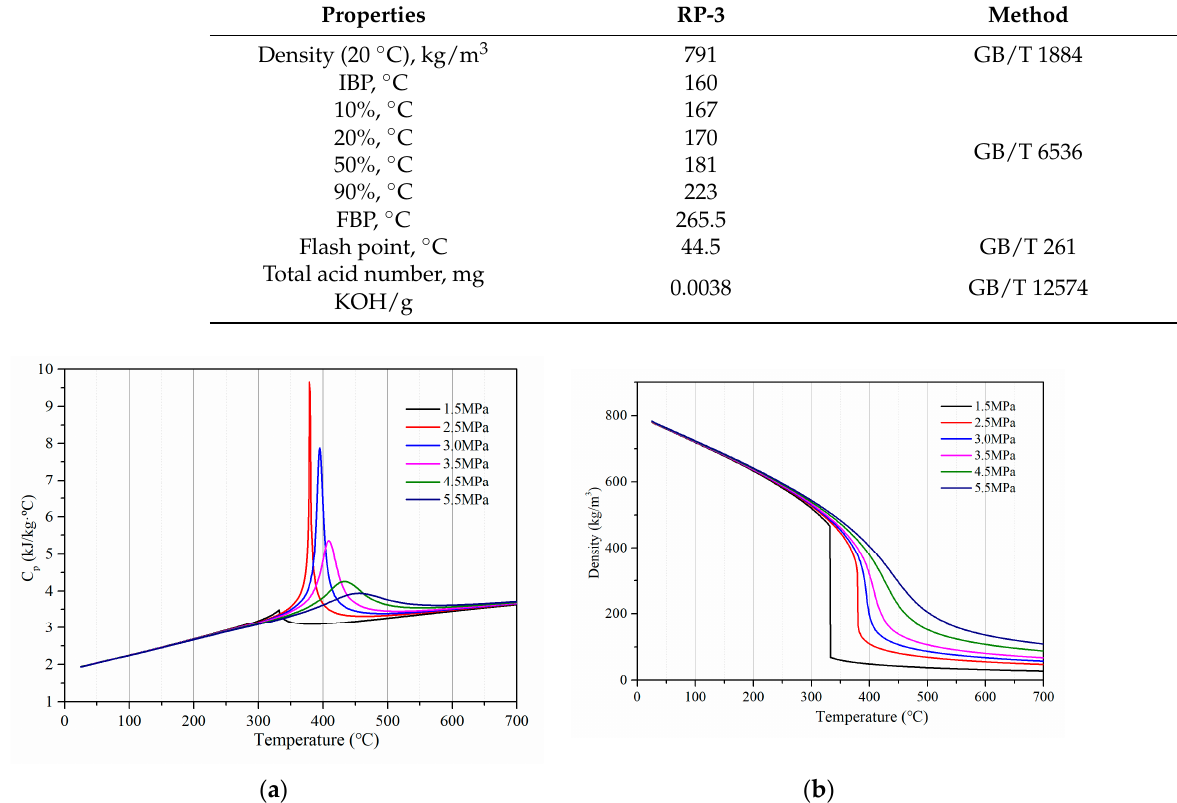
Figure 3. Temperature-dependent physical properties of RP-3 surrogate fuel under different pressures: ( a ) isobaric specific heat capacity and ( b ) density.